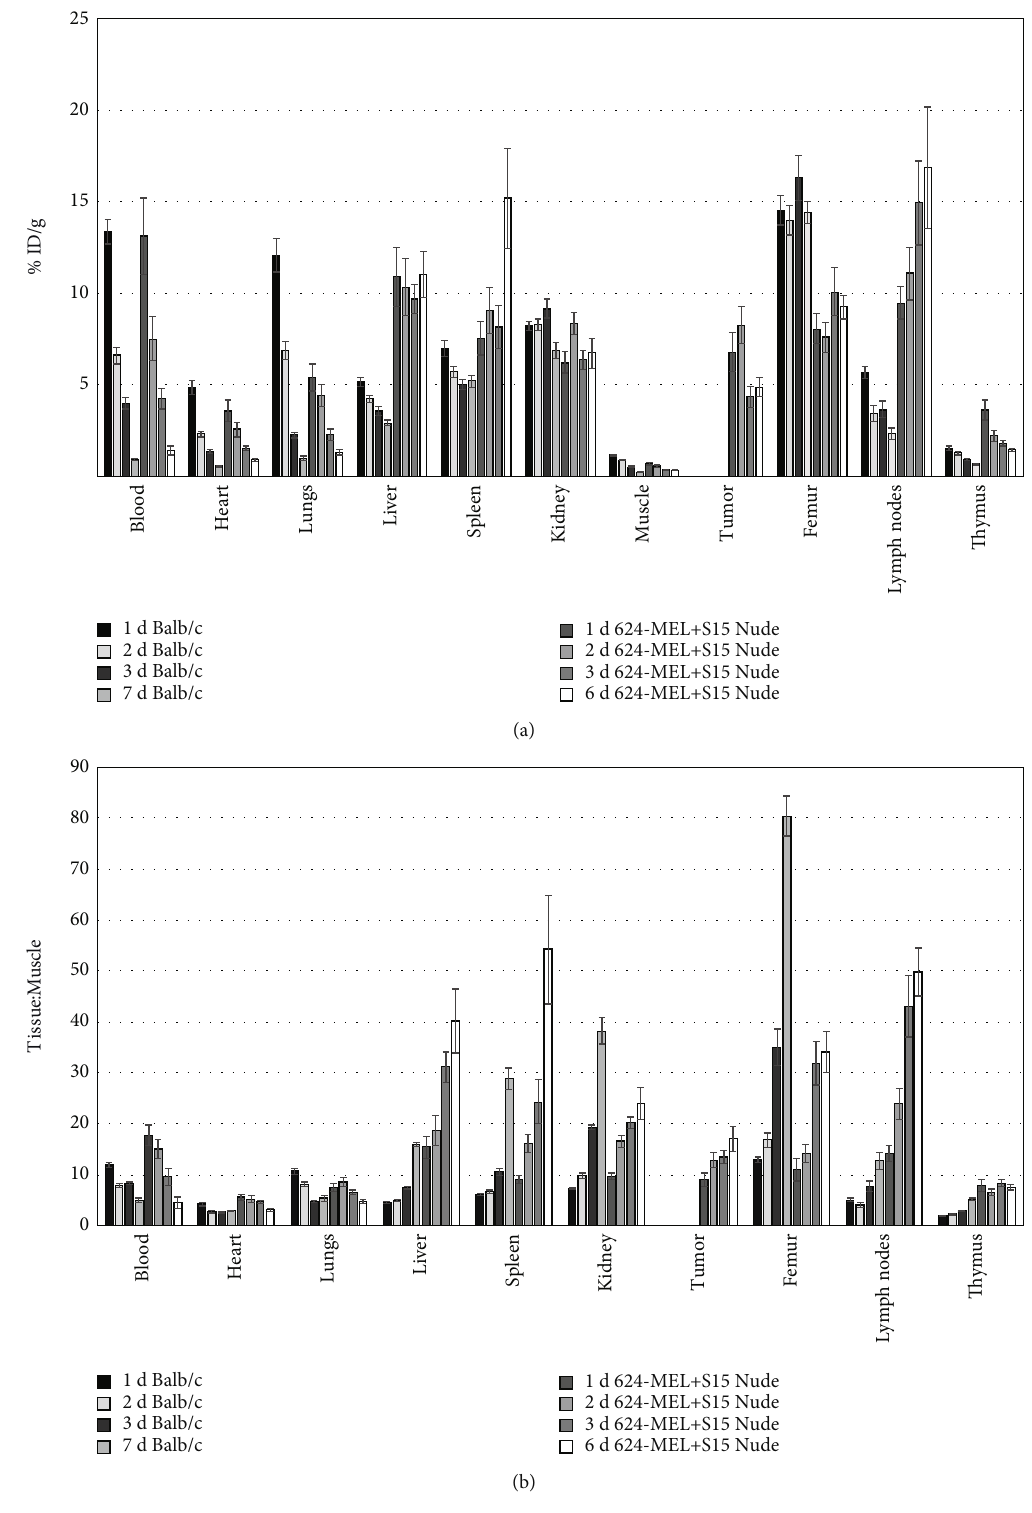
Figure 4: (a) Biodistribution (%ID/g (normalized to 20g mouse)) of [ 89 Zr]Zr-DFO-NC318 in MEL-624+S15 nude xenograft and Balb/c mice (immunocompetent) from 1d to 7 d. Each bar represents the mean % ID/g ± SE of [ 89 Zr]Zr-DFO-NC318 ( n = 7 to 10 for each time point). (b) Tissue (%ID/g) to muscle (%ID/g) ratios of [ 89 Zr]Zr-DFO-NC318 in MEL-624+S15 nude xenograft and Balb/c mice from 1 d to 7d. Each bar in the graph represents the meanratio ± SE of [ 89 Zr]Zr-DFO-NC318 ( n = 5 or 6 each time